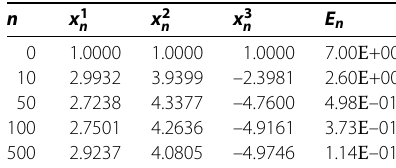
Table 2 Numerical results as regards Example 2 n x 1 n x 2 n x 3 n E